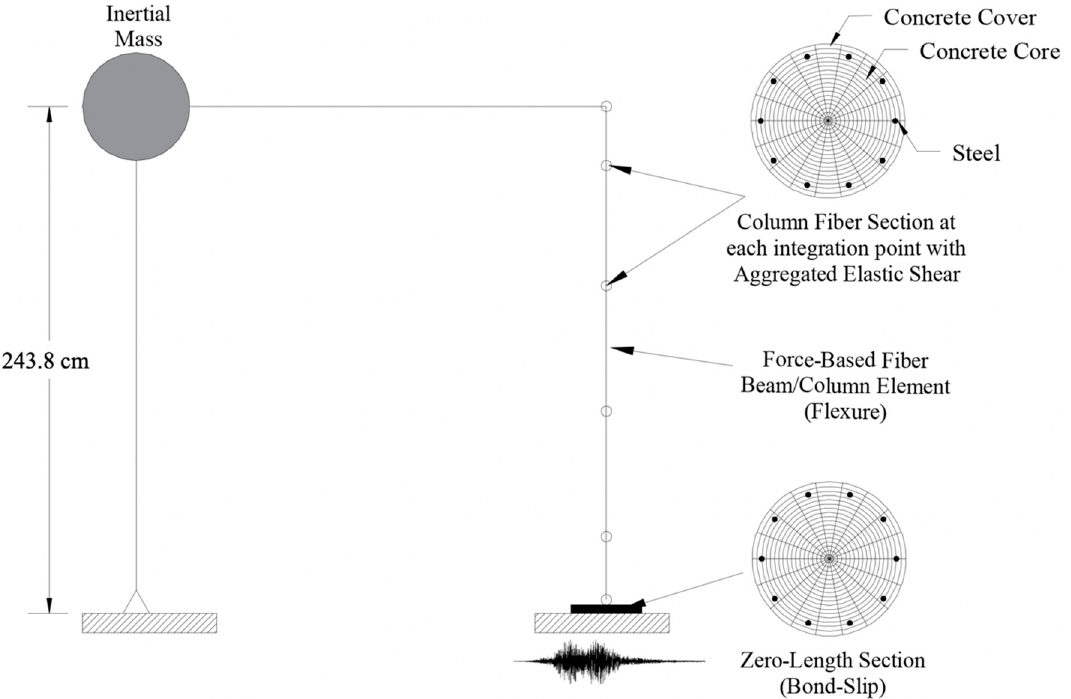
Figure 15. Model III.